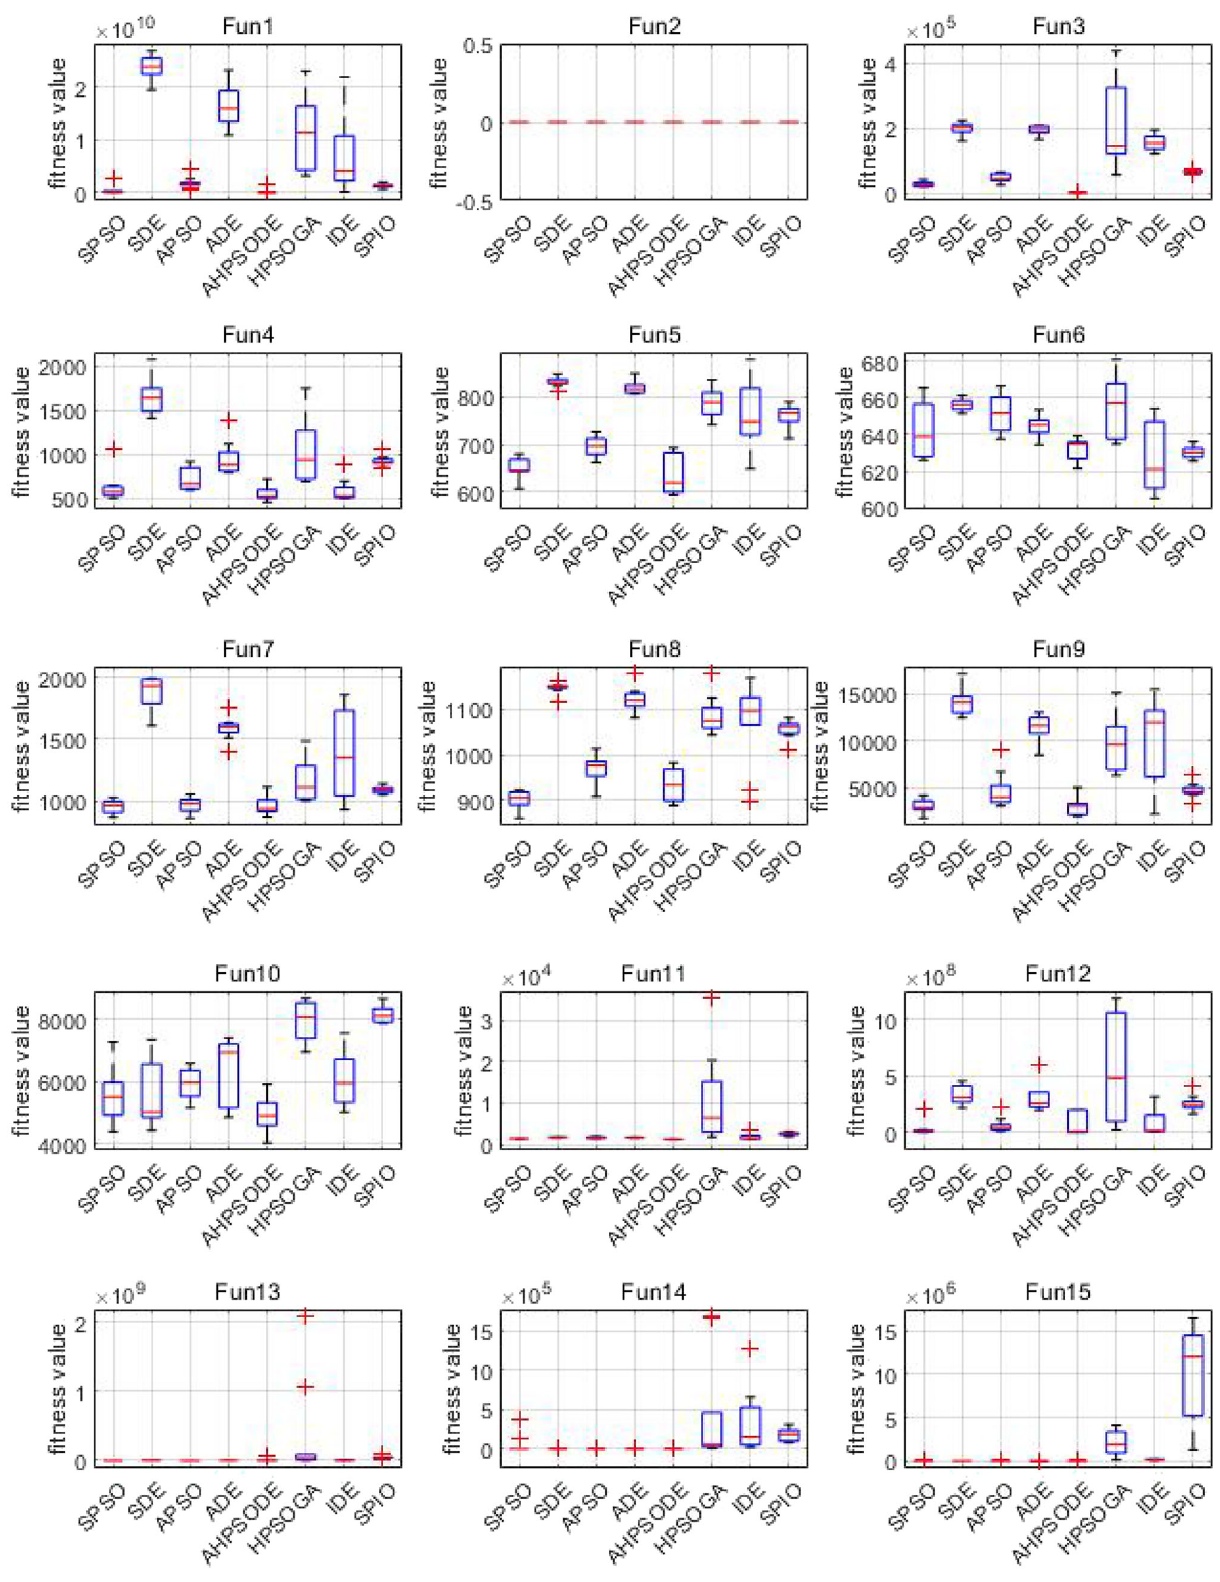
Fig. 19 Box plot of different algorithms on CEC 2017 at 30-D (Fun